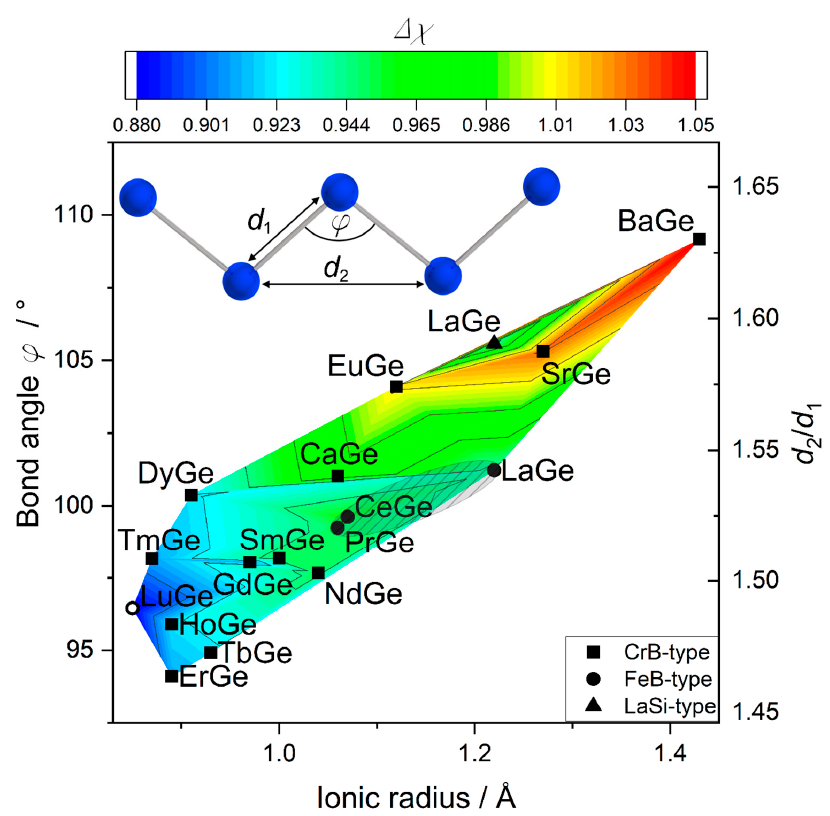
Figure 5. Relation between bond angle in the chains φ , ratio of the chain distances d 2 / d 1 and differ- ence in electronegativity (filled symbols—ambient pressure, open symbols—high-pressure synthe- sis). Striped ellipsoid marks the narrow field of ambient-pressure FeB-type rare-earth germanides.